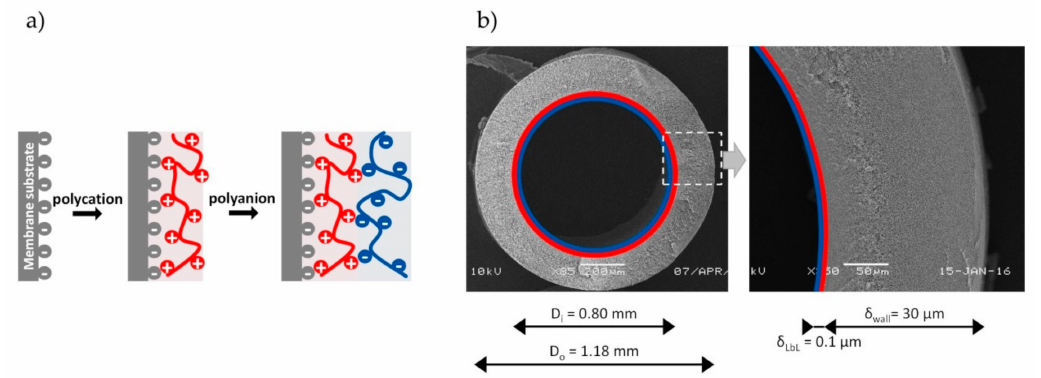
Figure 2. Principle of LbL technology: sequentially coating of a support membrane with charged polyelectrolytes ( a ), Microscopic pictures of a capillary fiber cross-cut showing coating layers including some characteristic dimensions ( b )